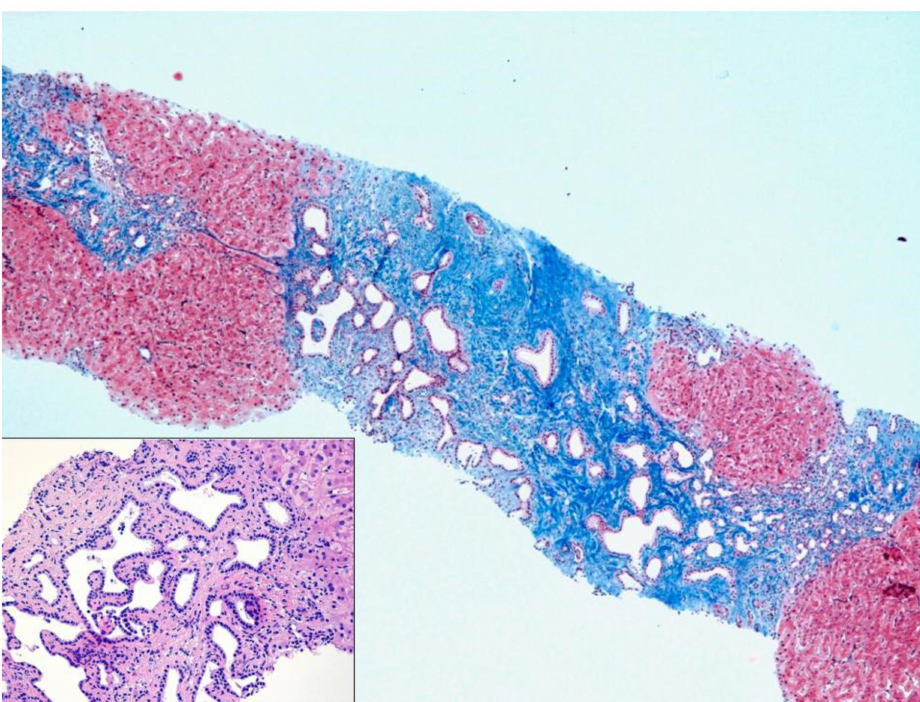
Figure 1. Liver biopsy demonstrating diffuse wide fibrous septa containing numerous bile ducts, separated by abundant collagen stroma without inflammatory infiltration, and scanty slit-like veins (Masson’s Trichrome, 40 × ). No cytological bile duct atypia is observed (insert, H&E 200 × ). She was finally placed on waiting list for OLT while receiving a chronic suppressive antibiotic therapy with amoxicillin/clavulanate, with no evidence of recurrent cholangitis at 4 weeks since start of